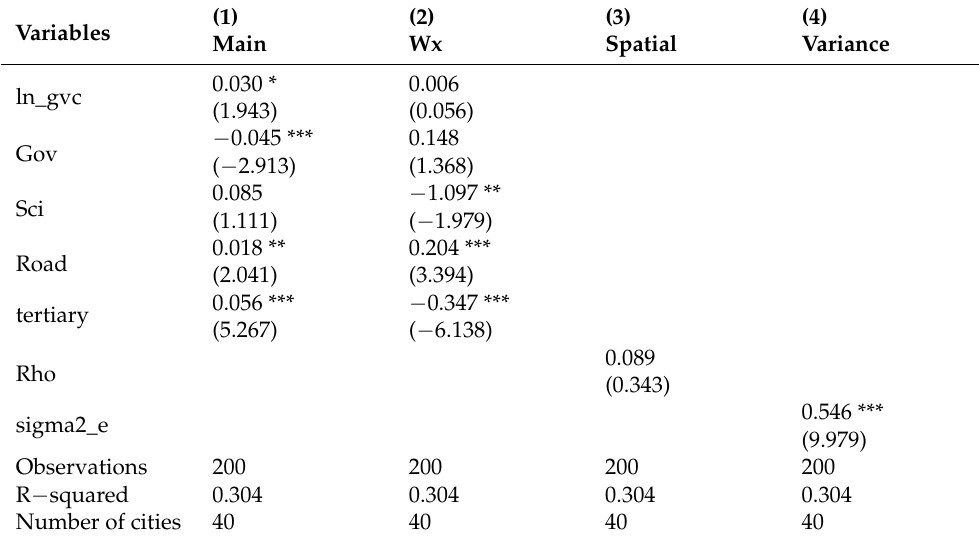
Table 10. Regression results of the urban construction levels.